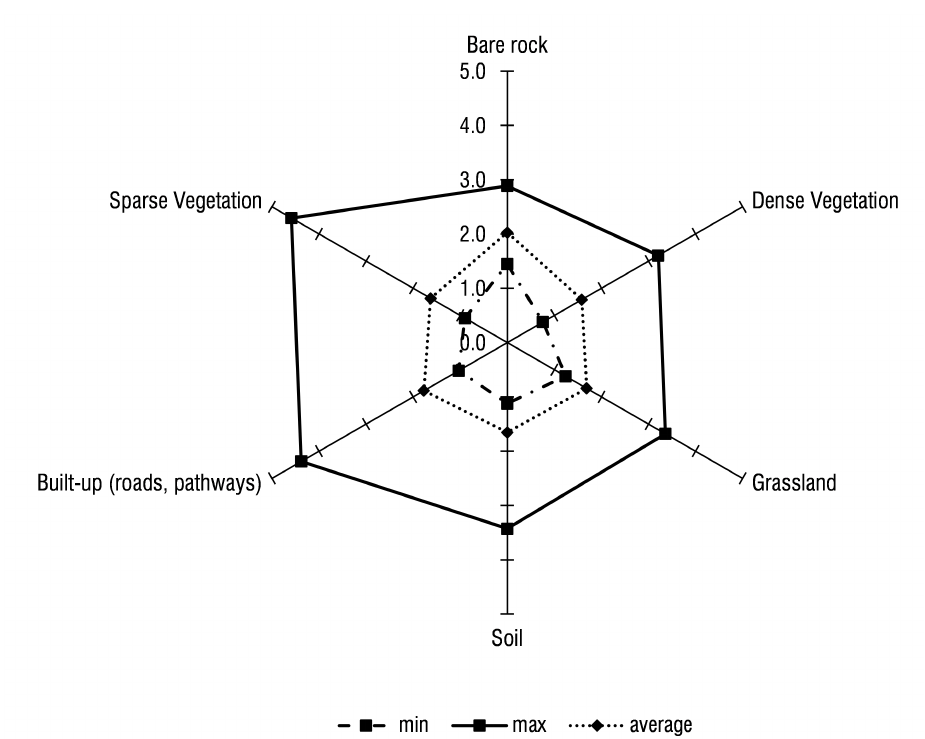
Figure 8: Chart with descriptive statistics of walkability values according to the land cover classes shown in the Figure